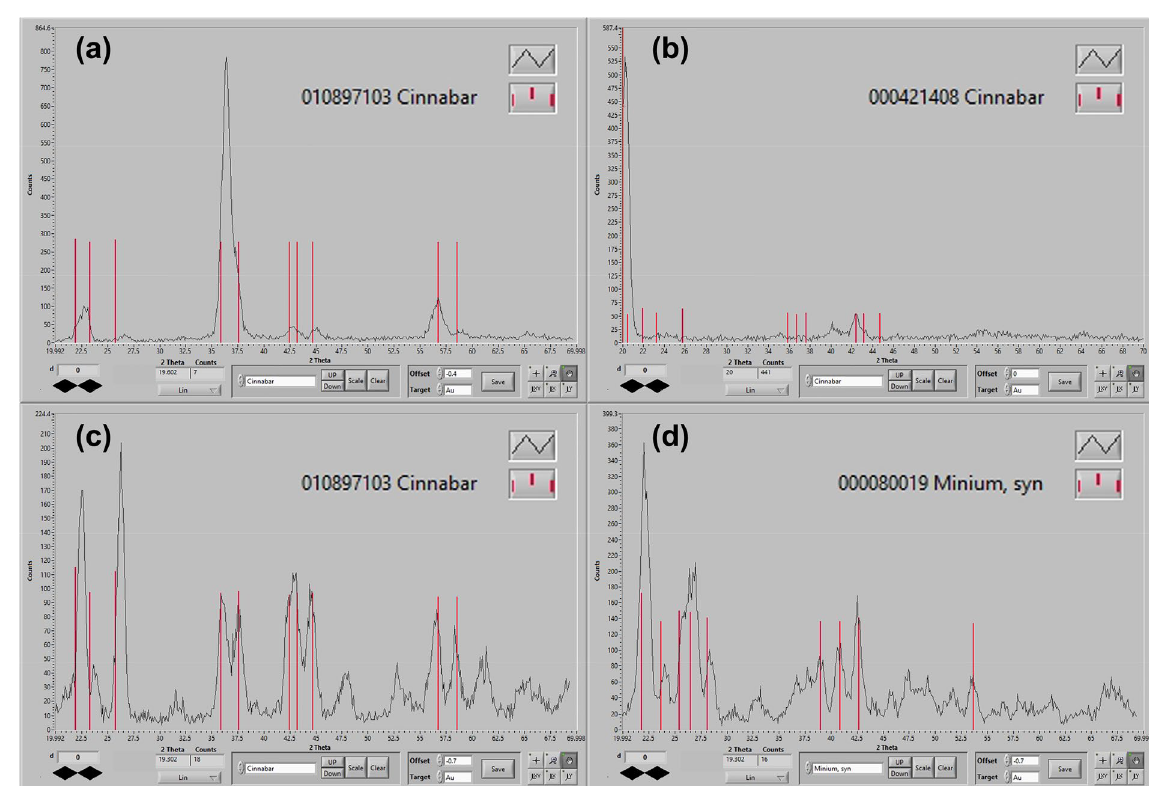
Fig. 8 Portable XRD patterns. a Raw mineral. b Polished gemstone. c Pigment powder. d Chinese ink